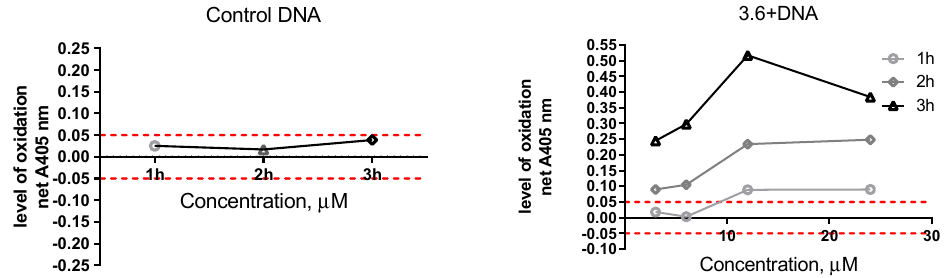
Figure 9. Variation in the net change of absorbance with increasing concentration of studied com- pound at different time periods. The control solution includes DNA, water, and KMnO 4 . The studied sample included DNA, compound 3.6 , and KMnO 4 .